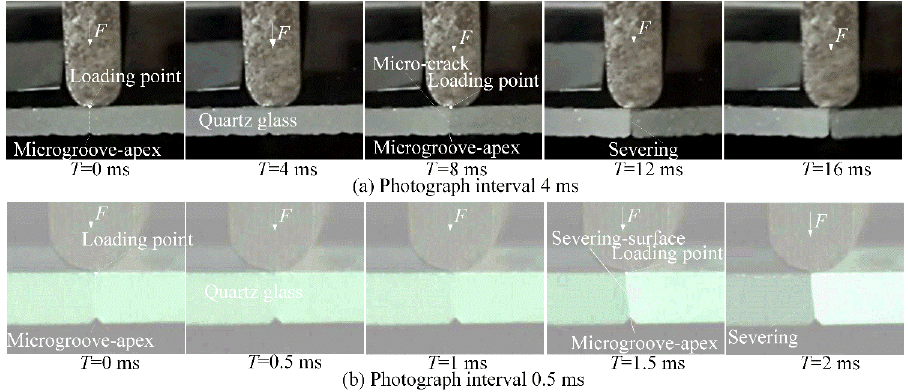
Figure 13. Micro-crack propagation process in static severing ( v = 20 mm/min).